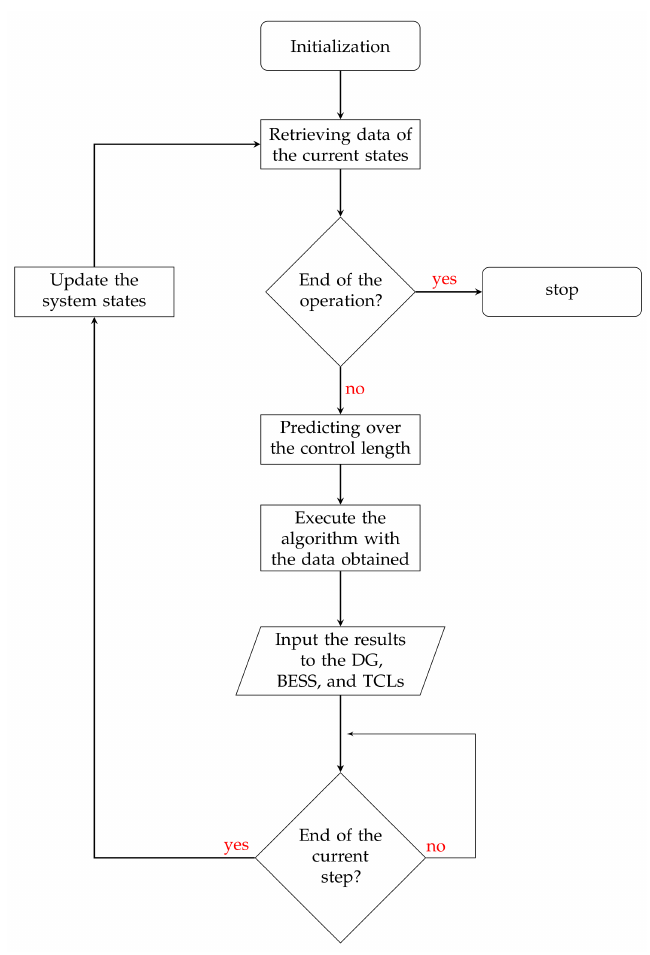
Figure 2. Flow chart of the proposed